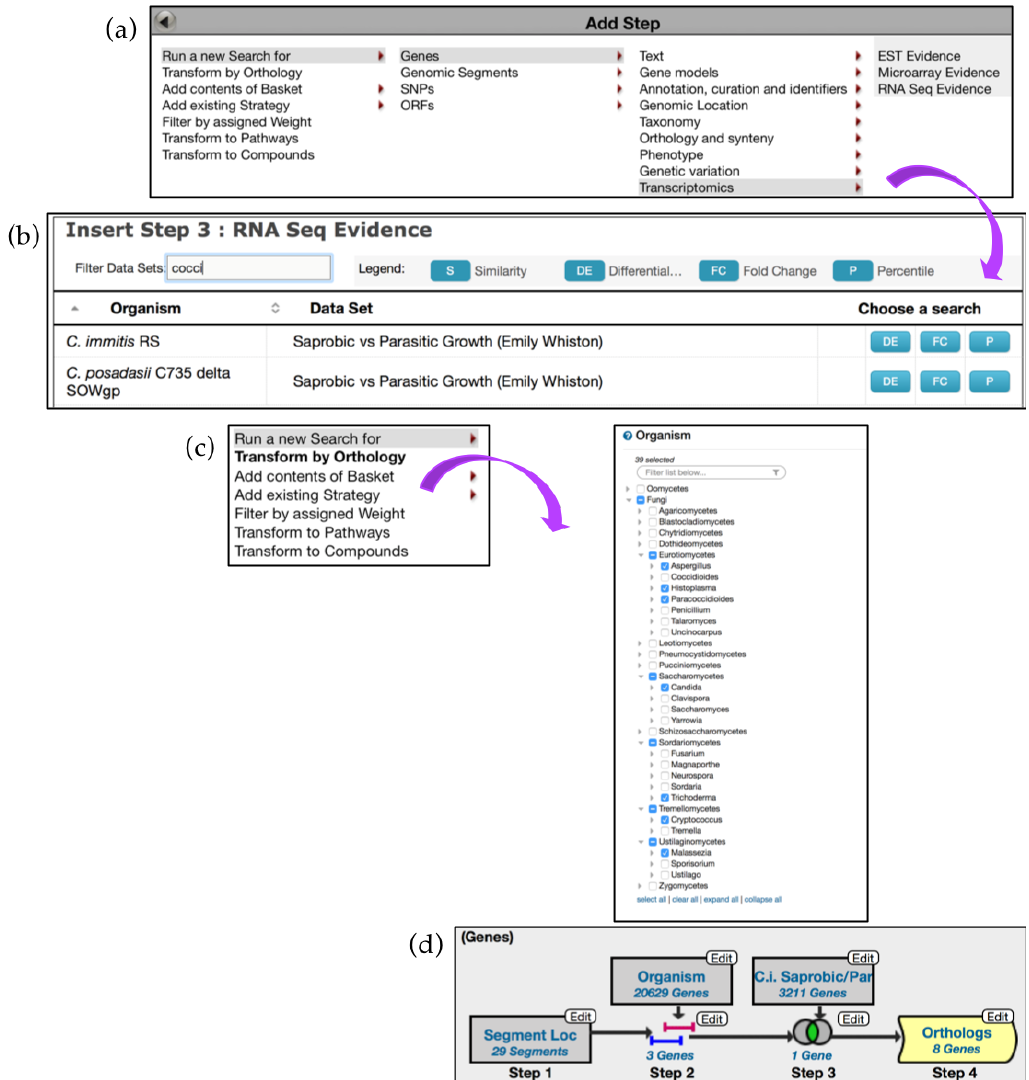
Figure 14. Using Genomic Location search to discover impact of Transposable Elements (TEs) on gene